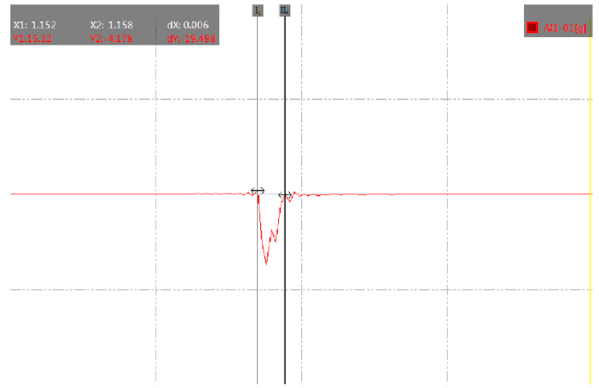
Figure 1. Diagram of the collected acceleration versus time for the impact load.